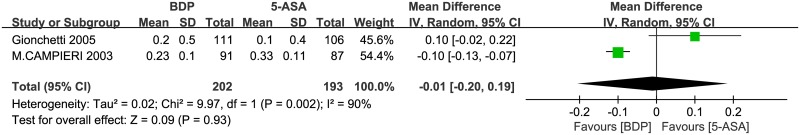
Forest plot of randomized controlled trials of BDP vs. 5-ASA in inducing Reduction of DAI parameters: rectal bleeding, in ulcerative colitis.BDP, beclomethasone dipropionate. 5-ASA, mesalazine. M-H, Mantel-Haenszel.